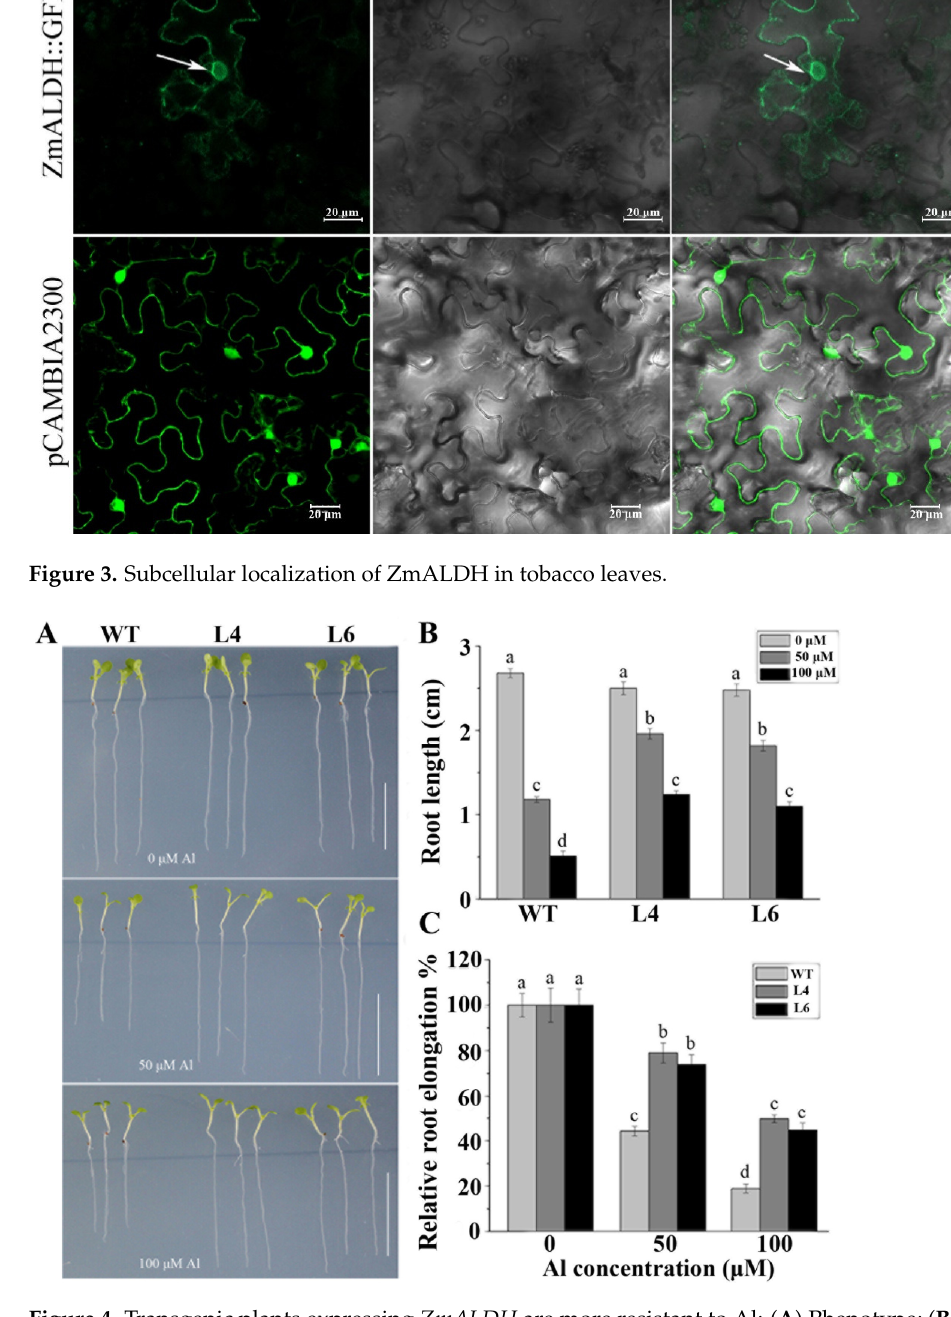
Figure 4. Transgenic plants expressing ZmALDH are more resistant to Al: ( A ) Phenotype; ( B ) Root length, and ( C ) Relative root elongation of WT and transgenic lines under normal and Al stress conditions. Seedlings of WT and two ZmALDH transgenic lines (L4 and L6) were grown on a plate containing 0 µ M, 50 µ M, and 100 µ M AlCl 3 for 5 d. Scale bar: 1.0 cm. Values represent mean ± SD ( n ≥ 15). Different letters indicate significant differences ( p < 0.01) (Tukey’s